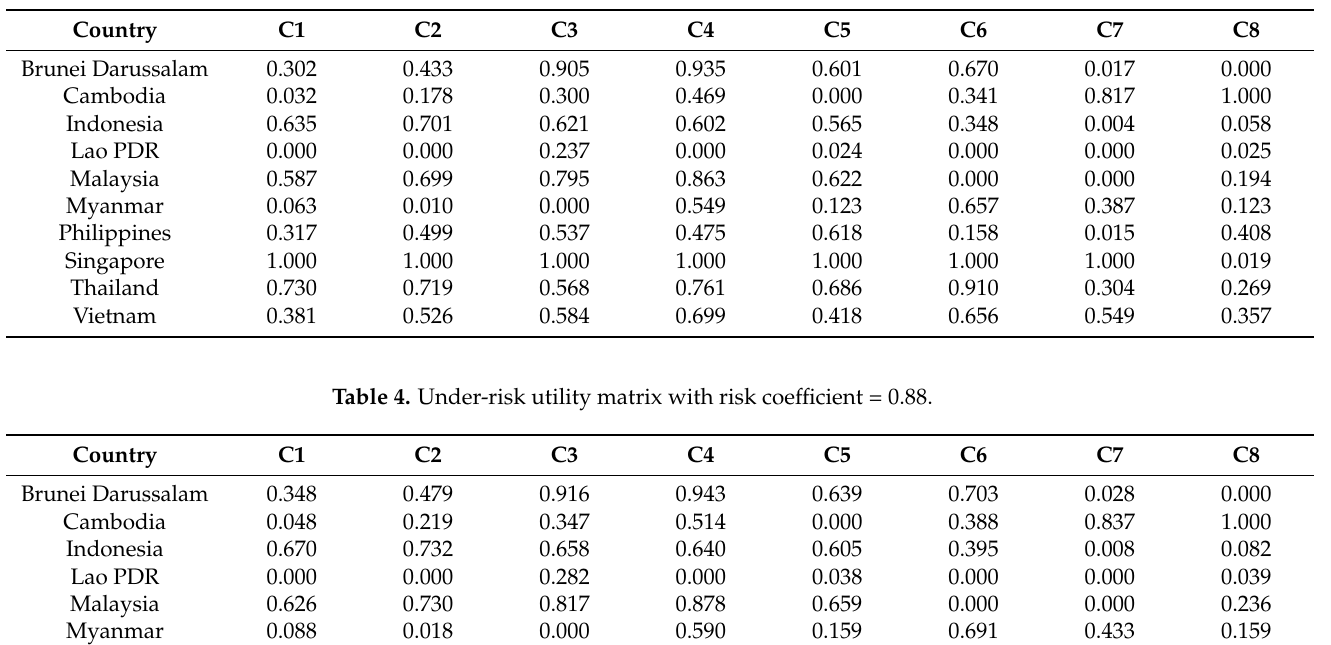
Table 3. Normalized decision matrix.